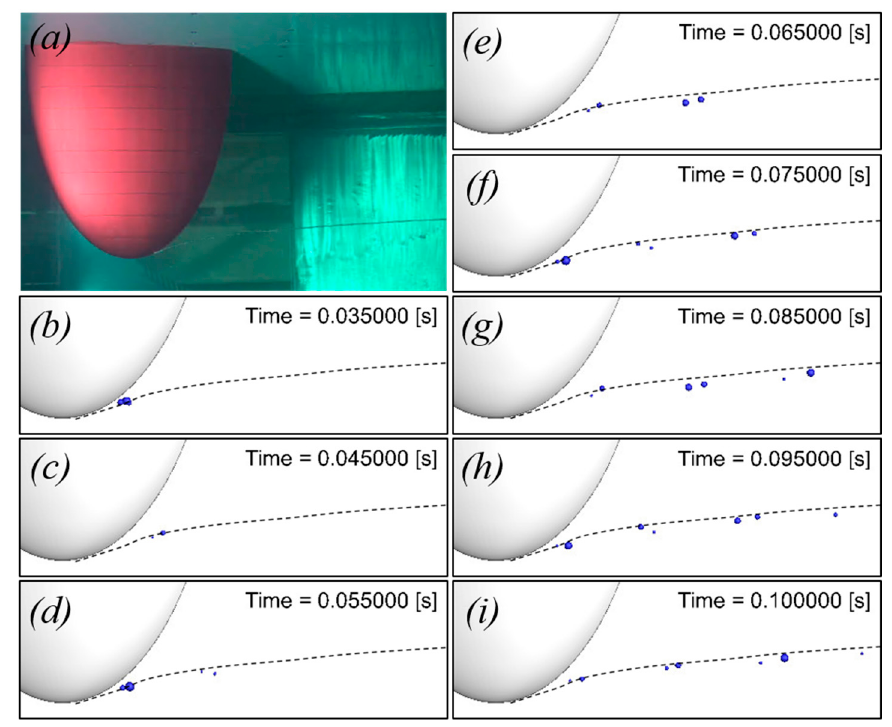
Figure 21. Comparison of wing-tip vortex cavitation between the experiment and bubble dynamics simulation; ( a ) experiment; ( b – i ) numerical results.